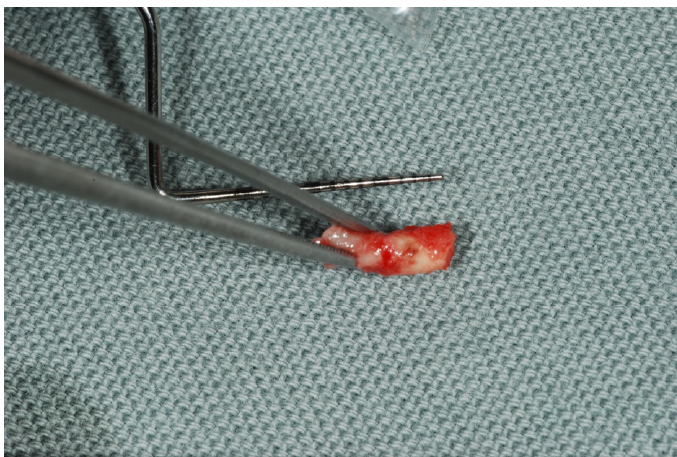
Figure 6. Bone specimen with a dimension of about 10 mm.